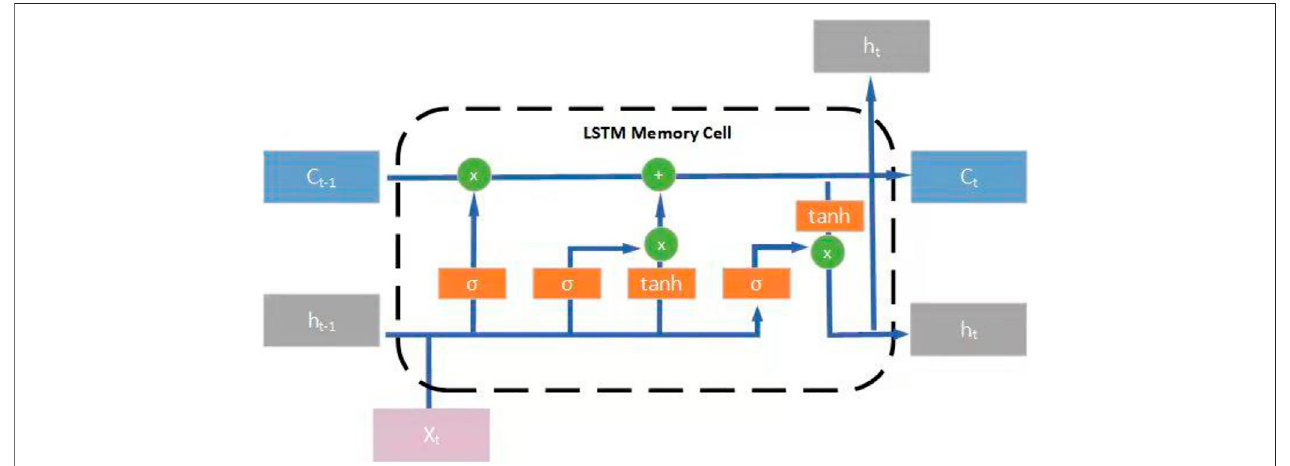
FIGURE 8 | LSTM module